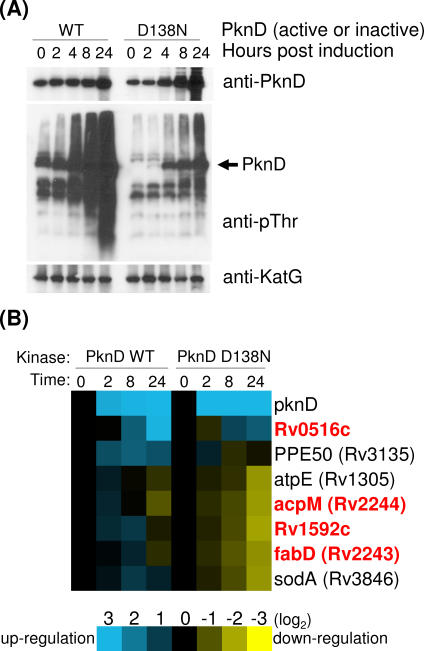
Efficient Overexpression of PknD and Concomitant Induction of Rv0516c in Logarithmically Growing Mtb
(A) Western blots showing kinase levels (anti-PknD) and kinase activity (anti-phosphothreonine) at 0, 2, 4, 8 and 24 h after induction of WT and Asp138Asn PknD (D138N). As a loading control, the amount of the KatG protein present at a constant level was monitored using anti-KatG antibodies. Addition of the inducer (acetamide) to WT Mtb (lacking an inducible PknD gene) caused no discernable change in the pattern of phosphoproteins (unpublished data). The presence of a band at the molecular weight of phosphorylated WT PknD at time zero may indicate that the kinase was already expressed (and autophosphorylated) at low levels in the absence of inducer. In contrast, phosphorylated Asn138Asn PknD accumulated only after the inducer was added.(B) Cluster diagram showing the eight genes with the largest time-dependent changes in transcript levels upon PknD induction. Expression levels are shown relative to a reference pool in which equal amounts of RNA from each sample were mixed and the value at time zero was normalized to 1.0. Microarray analysis revealed >2-fold induction or repression of 137 genes (Table S1). Among the eight most altered transcripts shown here, we observed robust induction (blue) of the putative anti-anti–sigma factor Rv0516c. Rv0516c expression increased much more upon expression of WT PknD than the attenuated mutant (Asp138Asn). Genes labeled in red are among those most reduced in expression during logarithmic phase growth of an Mtb sigF knockout mutant [21]. Color unit is fold change of gene expression.